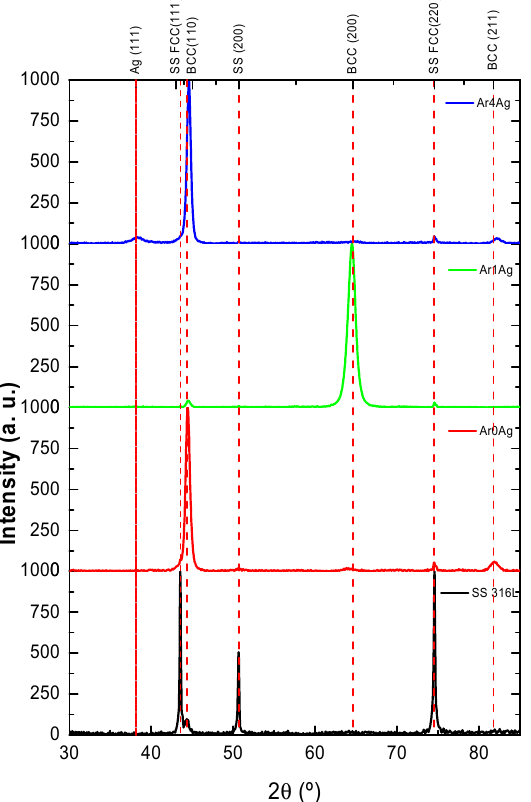
Figure 1. X-ray diffraction (XRD) diffraction patterns of stainless steel coatings deposited in Ar atmosphere.